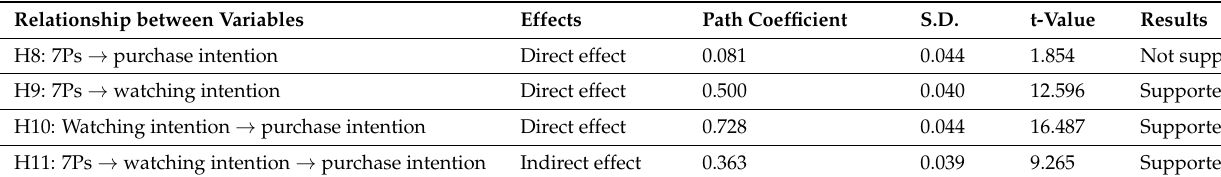
Table 5. Hypotheses testing for Model 3.